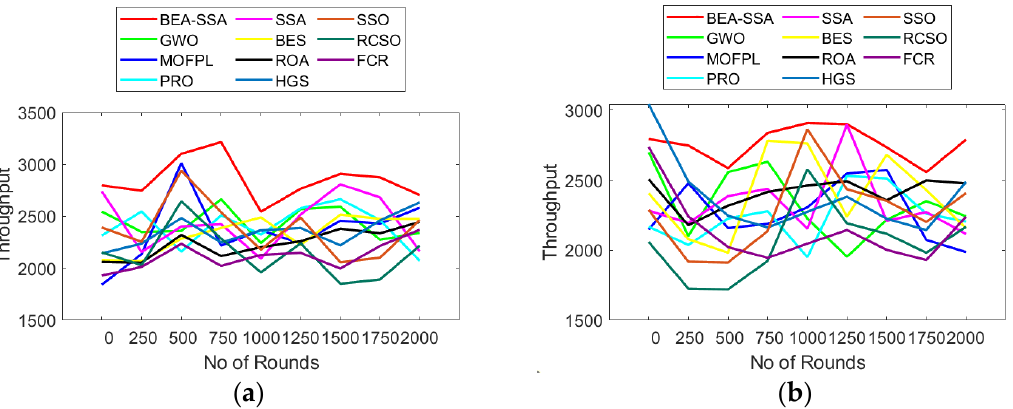
Figure 11. Throughput analysis using BEA ‐ SSA over other models [20–22,26] for node count of ( a ) 100 ( b ) 200.